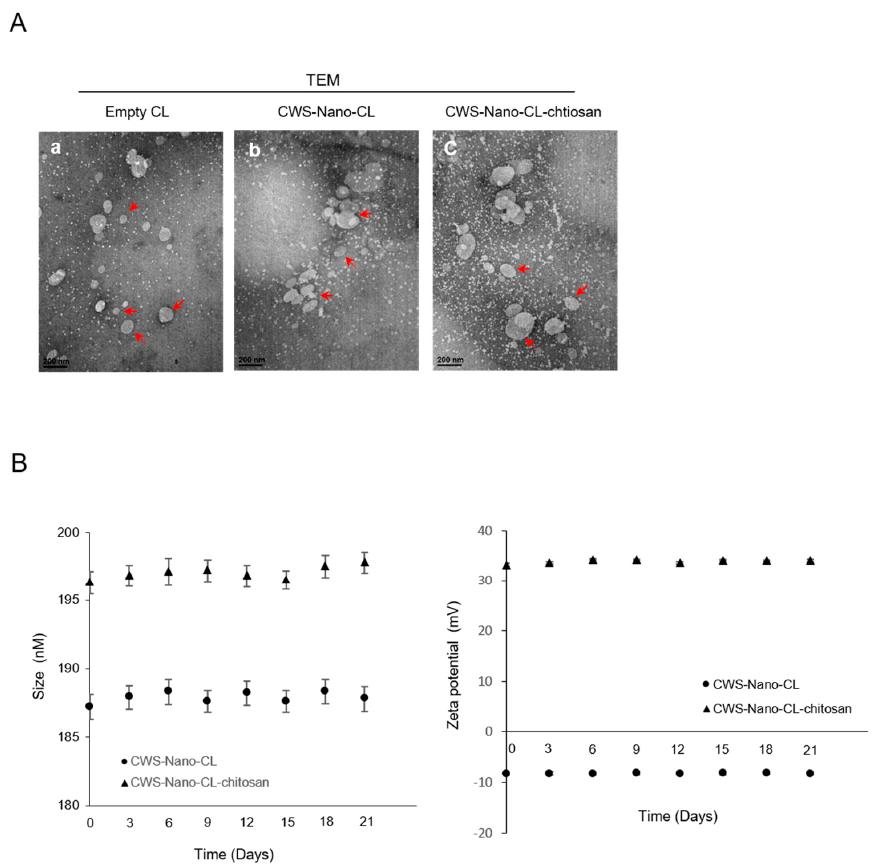
Figure 1. Characterization of the CWS-loaded formulations. ( A ) Transmission electron microscopy (TEM) images of empty CL, CWS-Nano-CL, and CWS-Nano-CL-chitosan. The red arrows indicate the prepared liposomes. All of the scale bars indicate 200 nm. ( B ) Colloidal stability of the CWS-Nano-CL, and CWS-Nano-CL-chitosan. Data are mean ± SD ( n = 3).